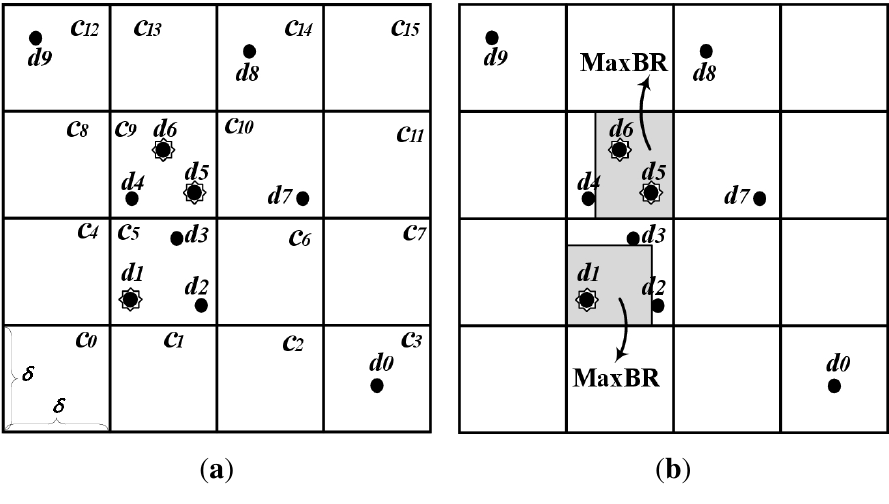
Figure 3. Data space D and deciding hot data items. ( a ) Data space D ; ( b ) Decision of hot data